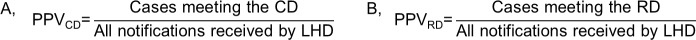
Formulae of the positive predictive value based on the case definition (PPVCD, A) and the reference definition (PPVRD, B). CD: case definition; RD: reference definition; LHD: local health department.